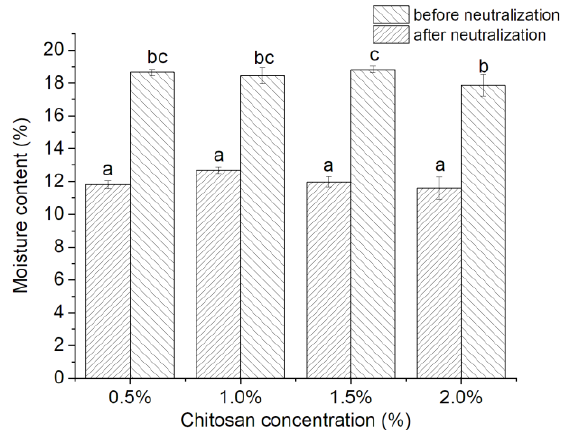
Figure 2. Effects of chitosan concentration on moisture contents of films before and after neutraliza- tion. Different letters indicate significant differences ( p <0.05).